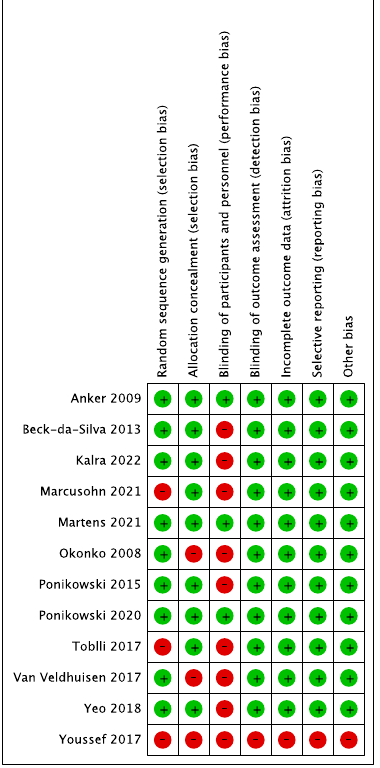
Figure 1. Preferred reporting items for systematic reviews and meta-analyses (PRISMA) flow diagram.